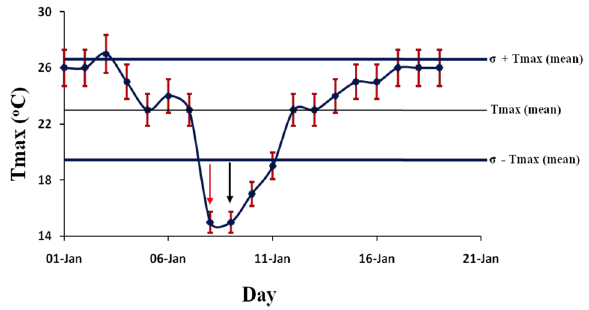
Figure 5. Day to day variations of the maximum temperature Tmax from January 1 to January 19, 2013, recorded at the epicenter site for the January 9, 2013, EQ event. The standard deviation magnitude of Tmax from the average values is shown by thick blue lines. The day of attaining a sudden minimum in temperature (January 8, 2013), is marked by red arrow head while the black arrow shows the EQ day.